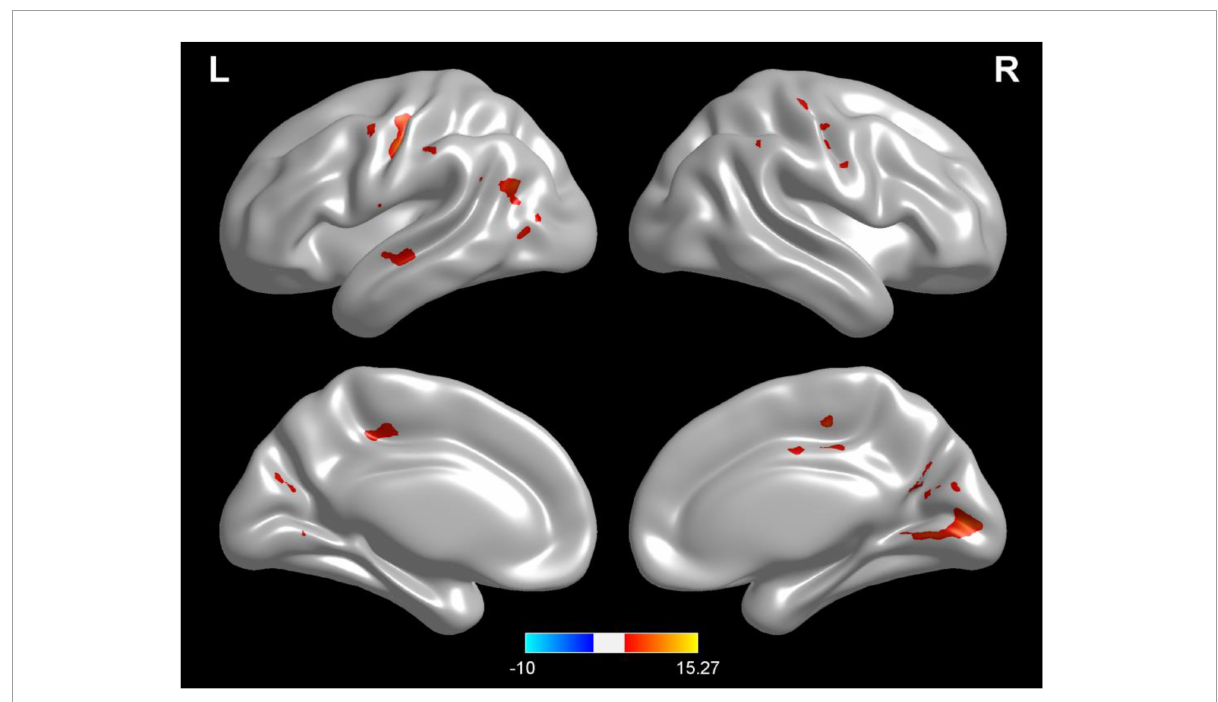
FIGURE2 Regional changes on the voxel-based three-dimensional displayed brain gray matter among participants when compared with test 3 in rehydration state and test 2 in dehydration state. Warm colors mean that the gray matter density among participants in the rehydration test was higher than that in the dehydration test; cold colors mean that the gray matter density among participants in the rehydration test was lower than that in the dehydration test; p < 0.05 after false-discovery rate correction, voxel threshold of cluster >